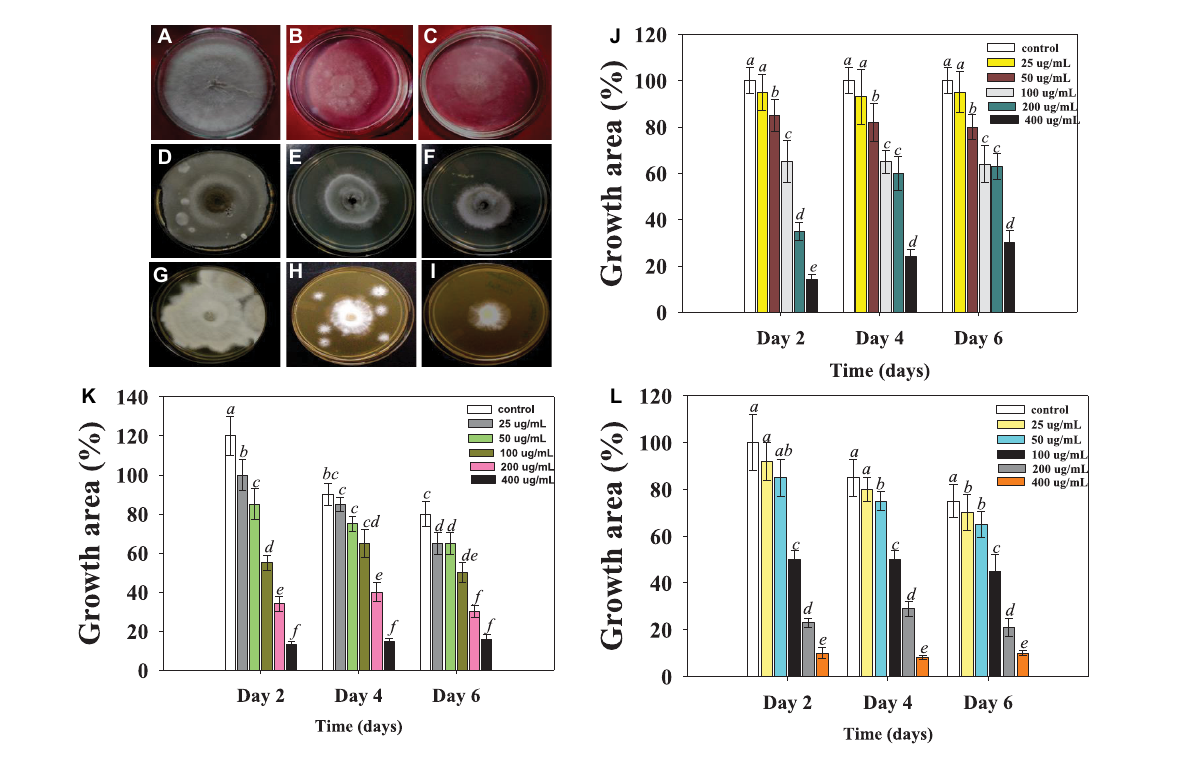
FIGURE2 Macroscopic examination depicting the Ag@ Cf L-NPs-induced inhibition in mycelia growth of phytopathogenic fungi; Rhizoctonia solani : control (A) , treated with 50 (B) , 100 µ g ml − 1 Ag@ Cf L-NPs (C) . Sarocladium sp.: control (D) , treated with 50 (E) , 100 µ g Ag@ Cf L-NPs ml − 1 (F) , Fusarium oxysporum : control (G) , treated with 50 (H) , 100 µ g ml − 1 Ag@ Cf L-NPs (I) . In this figures, (J–L) represents the bar diagrams showing the numerical data in terms of percentage of growth area as compared to mycelia growth of untreated control done in triplicates ( n = 3). Corresponding error bars represents standard deviation (S.D) of three replicates (S.D, n =